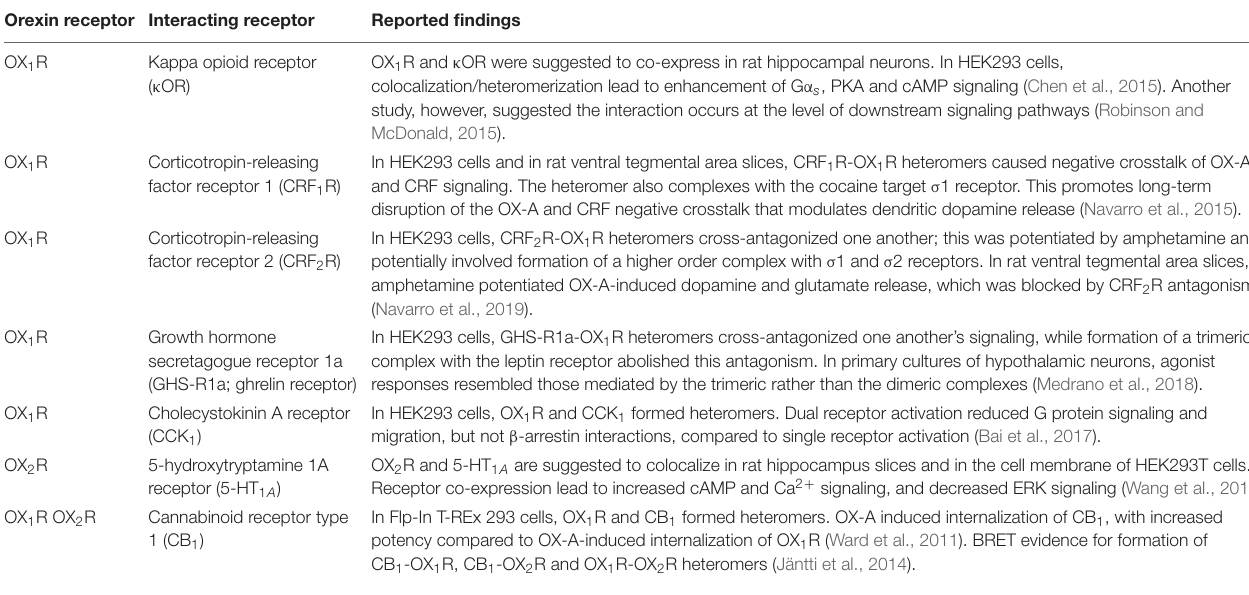
TABLE 1 | Select reported interactions between orexin receptors and other GPCRs in native and recombinant environments. Orexin receptor Interacting